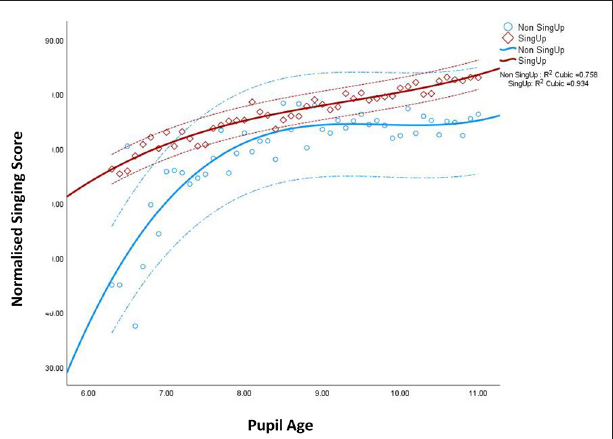
FIGURE 1 | Association between children’s mean decimal age and singing competency, normalized across two singing tasks using two rating scales, for participating pupils within and without the Sing Up programme, N = 11,258 children ( N = 13,096 assessments); Sing Up = 71 schools, Non-Sing Up = 56 schools. Data points represent the means for children’s decimalised age related to their school grouping (either Sing Up and Non-Sing Up ). Dotted lines represent standard deviations.